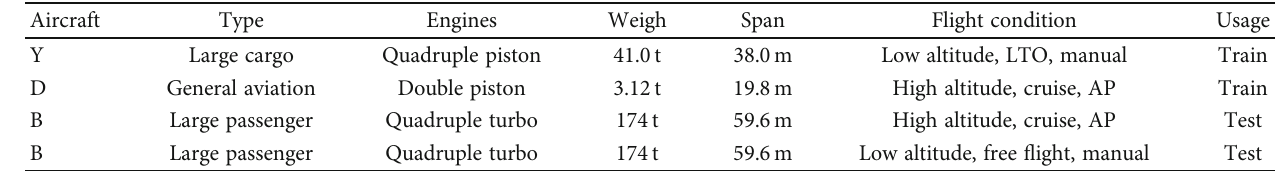
Table 1: Aircrafts and fl ight